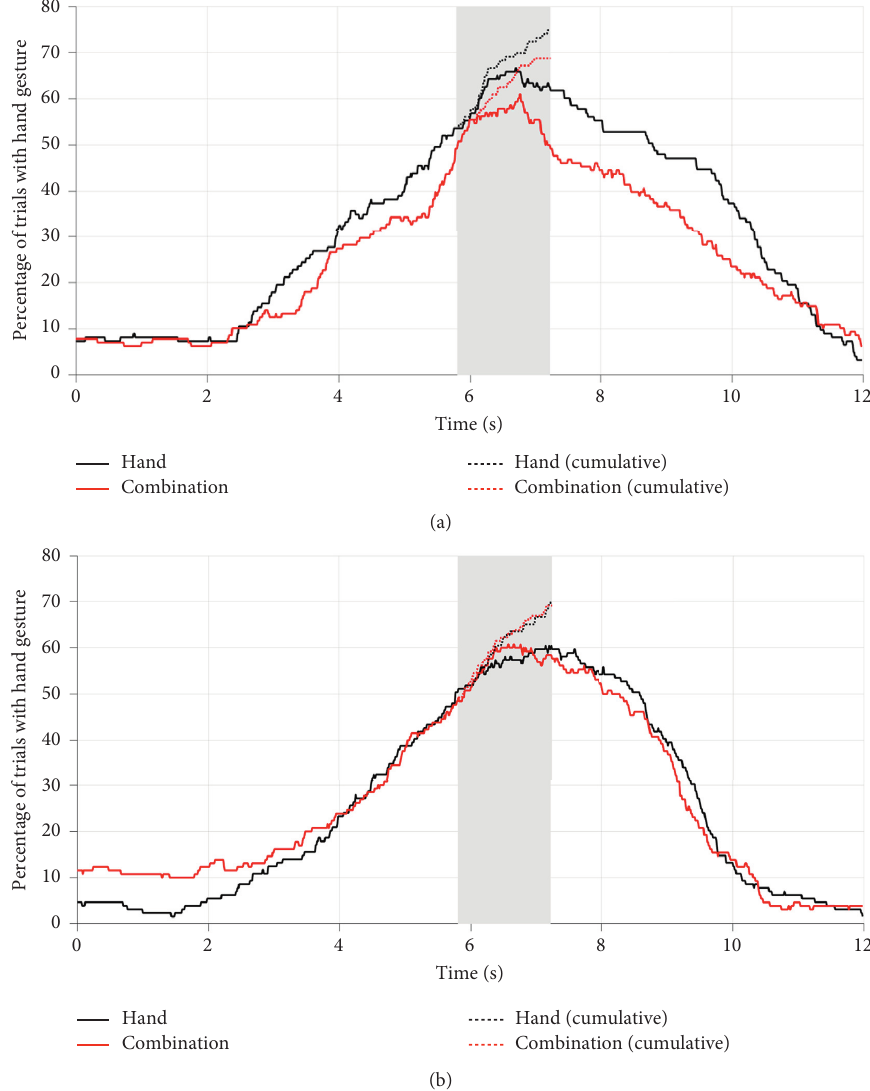
Figure 4: Percentage of trials in the Hand and Combination conditions in which participants had their hand raised, as a function of elapsed time. (a) Only trials in which the AV could yield are considered ( n � 123 for the Hand condition and n � 128 for the Combination condition). (b) Only trials in which the AV did not yield are considered ( n � 129 for the Hand condition and n � 130 for the Combination condition). The dotted lines represent the percentage of trials in which the hand gesture was used up to that point. The grey area represents the region in which hand gestures could be picked up by the AV (distance to pedestrian between 30 and 50m).